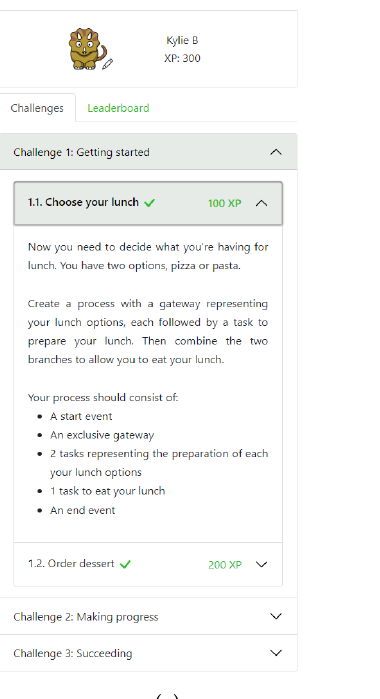
Figure 11. Competition version main page—exercise list view and leaderboard tabs. ( a ) Exercise list.